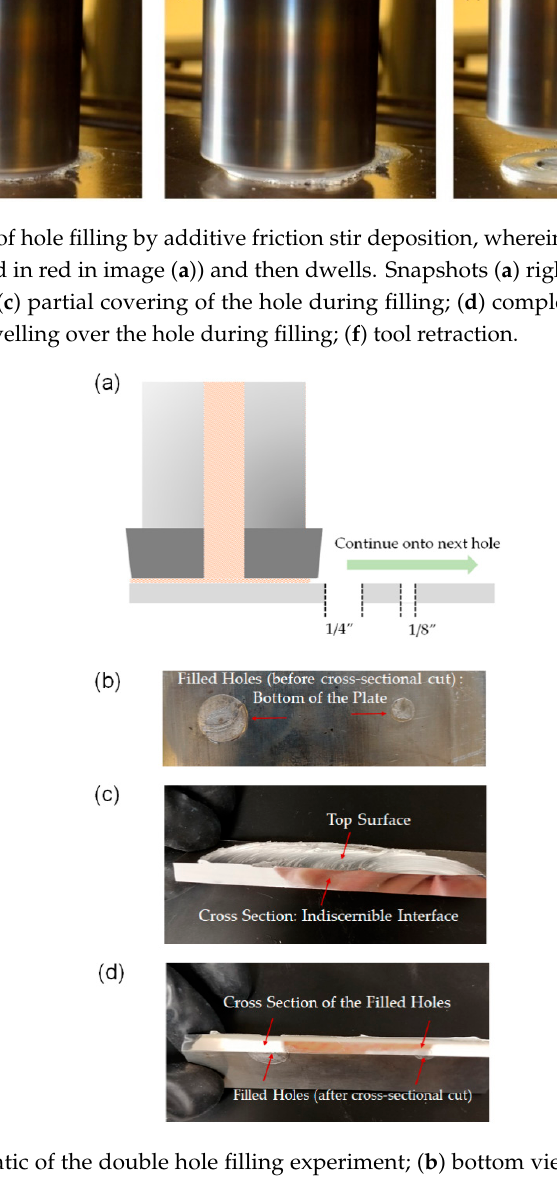
Figure 3. ( a ) Schematic of the double hole filling experiment; ( b ) bottom view of the filled holes; ( c ) cross-sectional views of the filled holes (holes cut in half); ( d ) underside of the cross-sectional view of the filled holes.